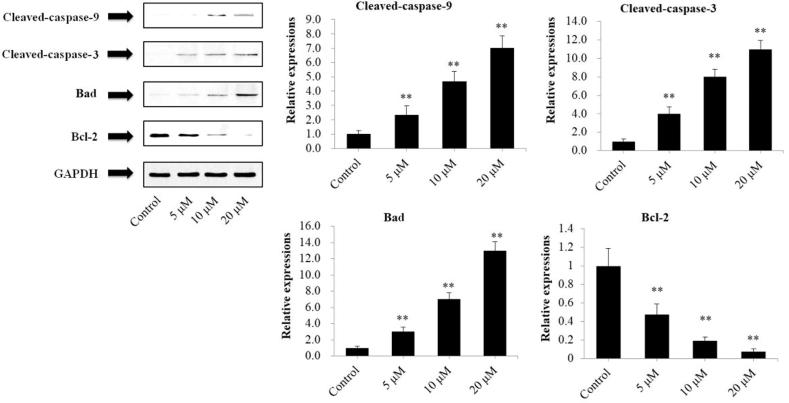
Exposure of U266 cells to DMEC resulted in upregulation of C-3, C-9 and Bad, and downregulation of Bcl-2. U266 cells were treated with DMEC (5, 10, and 20 μM) for 24 h and protein expression levels were determined by western blotting analysis using antibodies against C-3, C-9, Bad and Bcl-2. Data are presented as the mean ± standard deviation (n = 4). **p < 0.01 vs. control group.